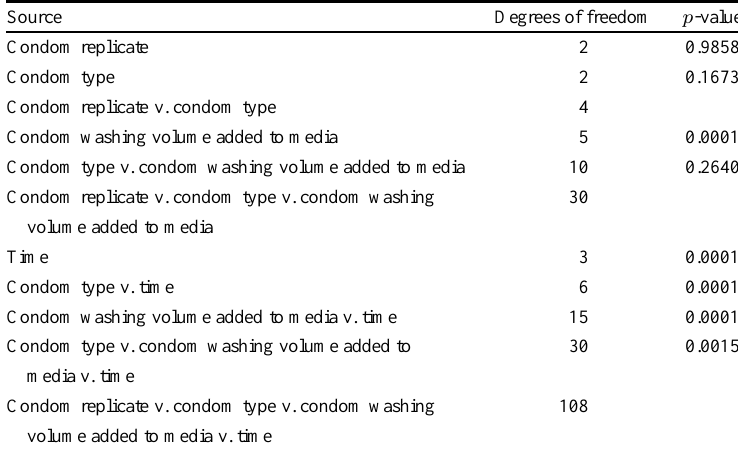
Analysis of variance table for cell viability (MTT